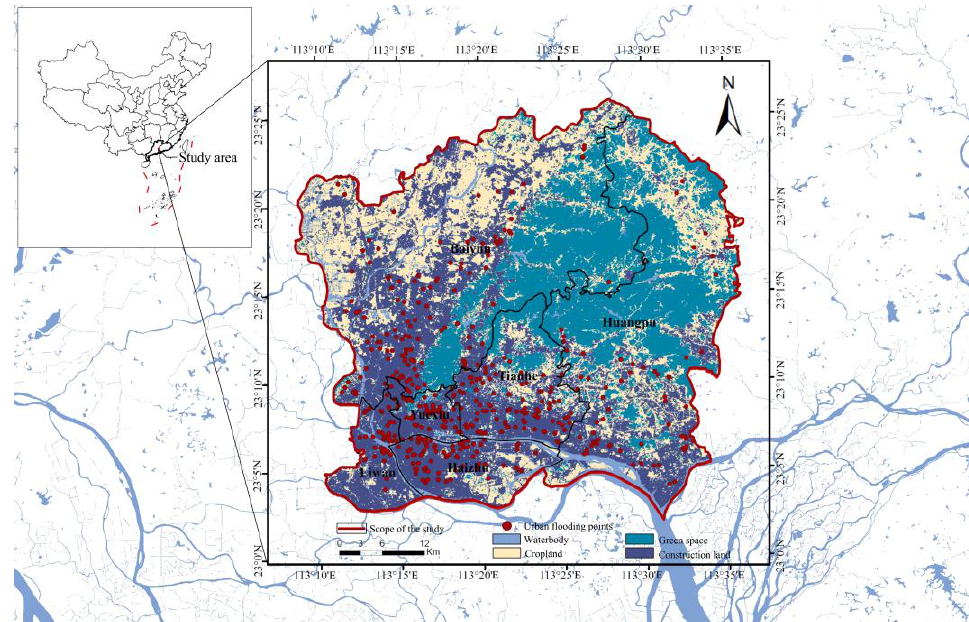
Figure 2. Study area.